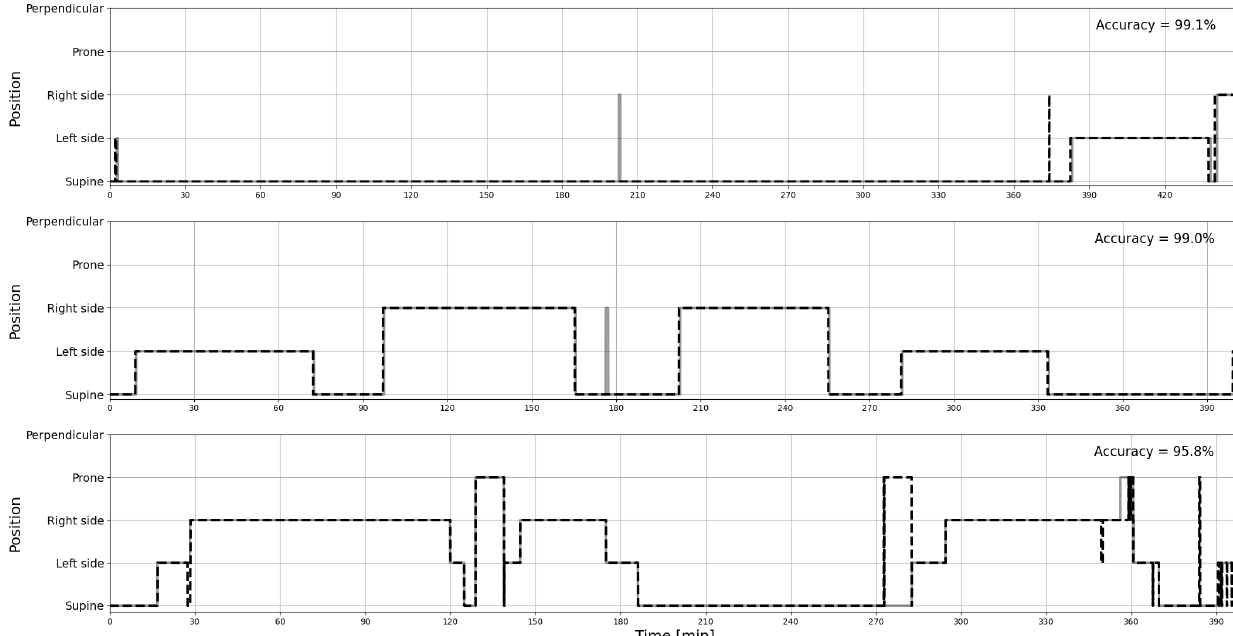
Figure 2. The sample curves of actigraphy signals recorded by PSG (solid line) and estimated from Clebre (dashed line), selected to show an almost perfect match ( top ), a small level of error ( middle ), and a moderate level of error ( bottom ), respectively.